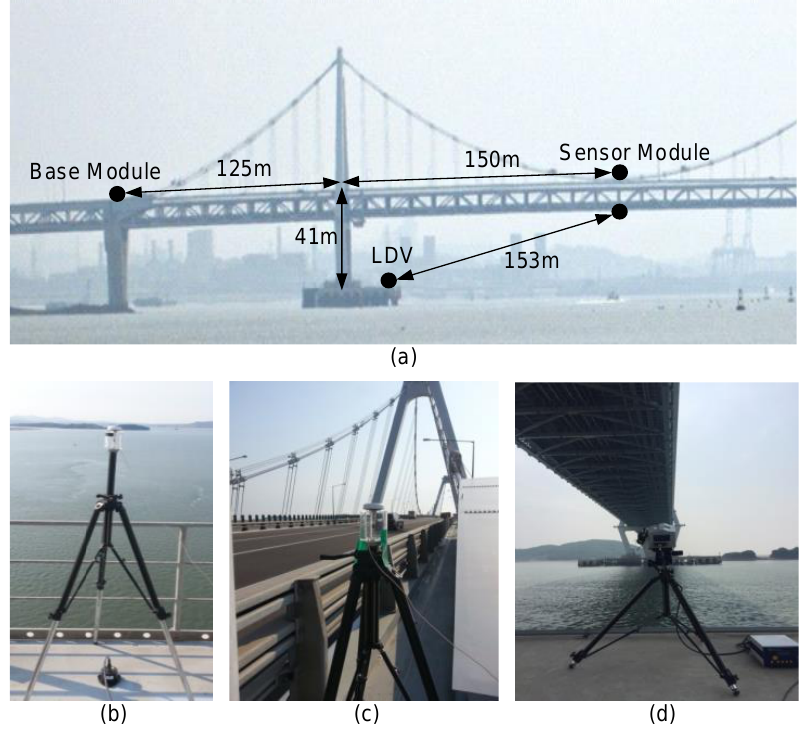
Figure 12. System configuration for the displacement measurement at Yeongjong Grand Bridge: ( a ) locations of sensors; ( b ) sensor module; ( c ) base module and; ( d ) LDV for reference displacement measurement.